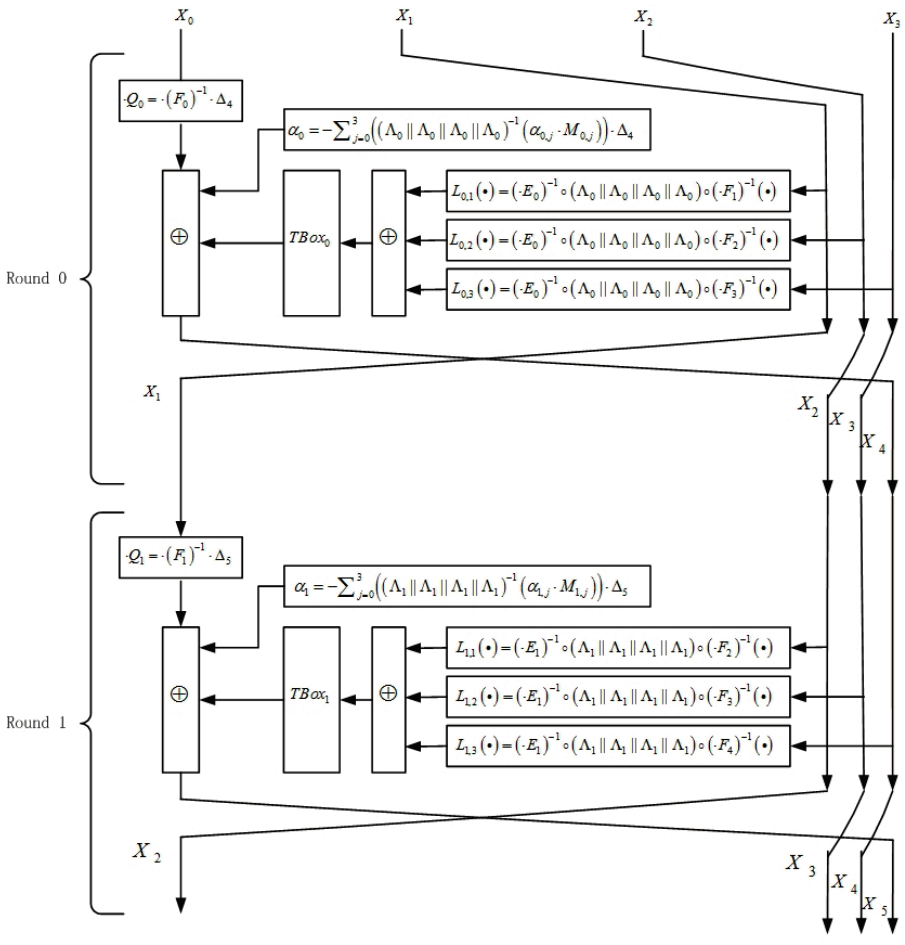
Figure 3. The structure of round 0 and round 1.